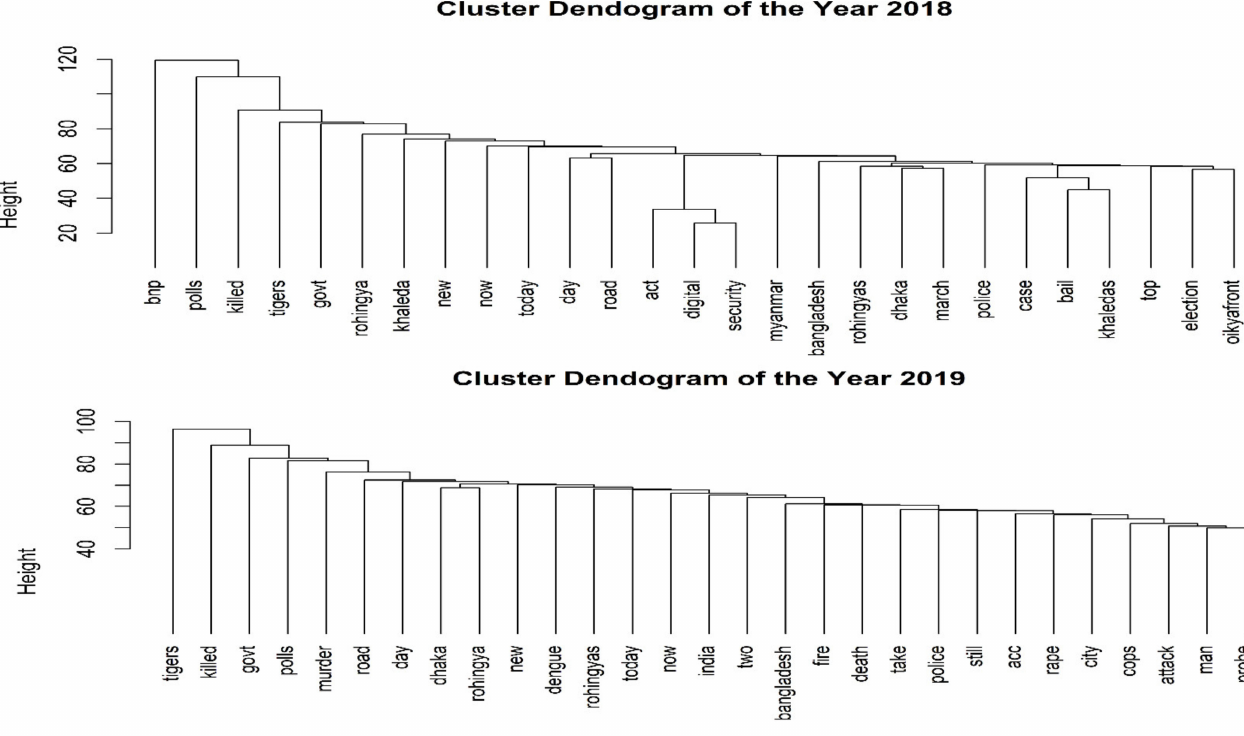
Figure 6. Clustering of the Headlines of Two